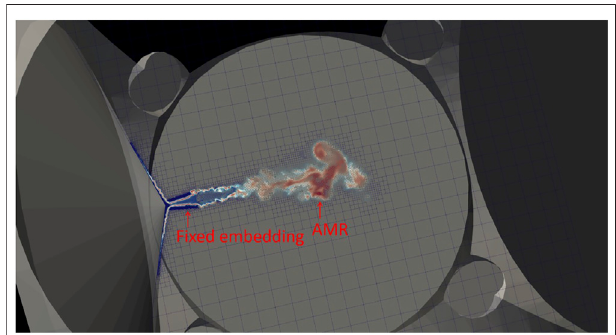
FIGURE 1 | Schematic of the numerical setup used in this work. The computational domain is the Sandia Constant Volume chamber. Mesh re fi nementbasedonboth fi xedembeddingandAMRareusedtoensureawell resolved fl ow fi